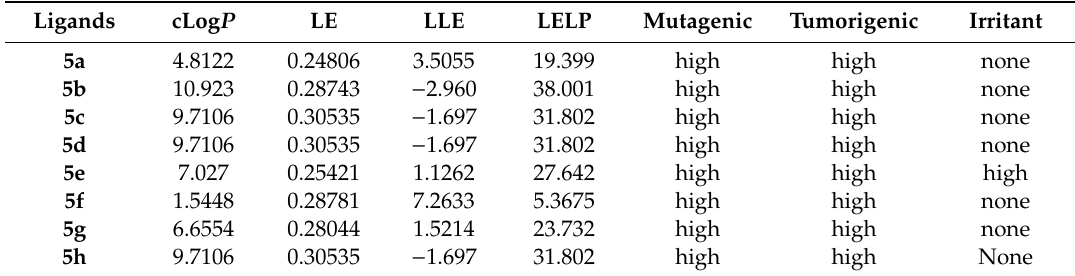
Table 3. Predicted ligand e ffi cacy